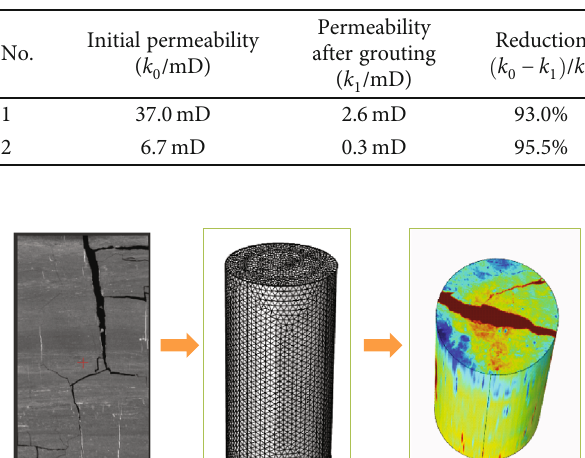
Figure 9: CT scanning results of coal sample 2#: (a) before grouting, (b) after grouting. Table 2: Variations of permeability of coal samples before and after grouting.